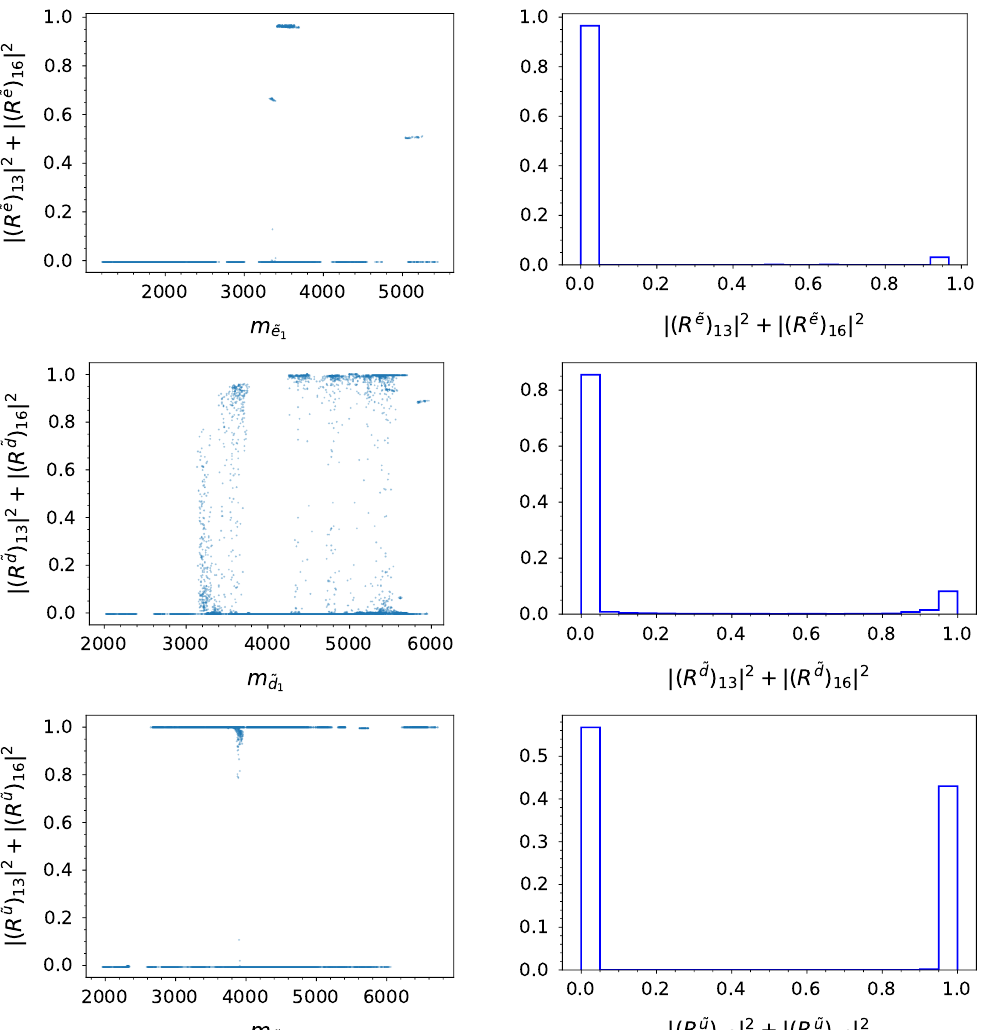
Figure 15 . The mass of the lightest sparticle for up and down type squarks and sleptons is plotted against the third generation content for the given particle on the left panels. When the third generation content is close to 0, the sfermion features a second and first generation maximally mixed state. For low mass down squark and slepton states, an admixture of first and second generation is favoured. The right panels illustrate the actual proportion of points that belong to these two extreme flavour cases. The sfermion mixing matrices R ˜ f ( ˜ f = ˜ u, ˜ d, ˜ e ) are defined according to the SLHA 2 standard